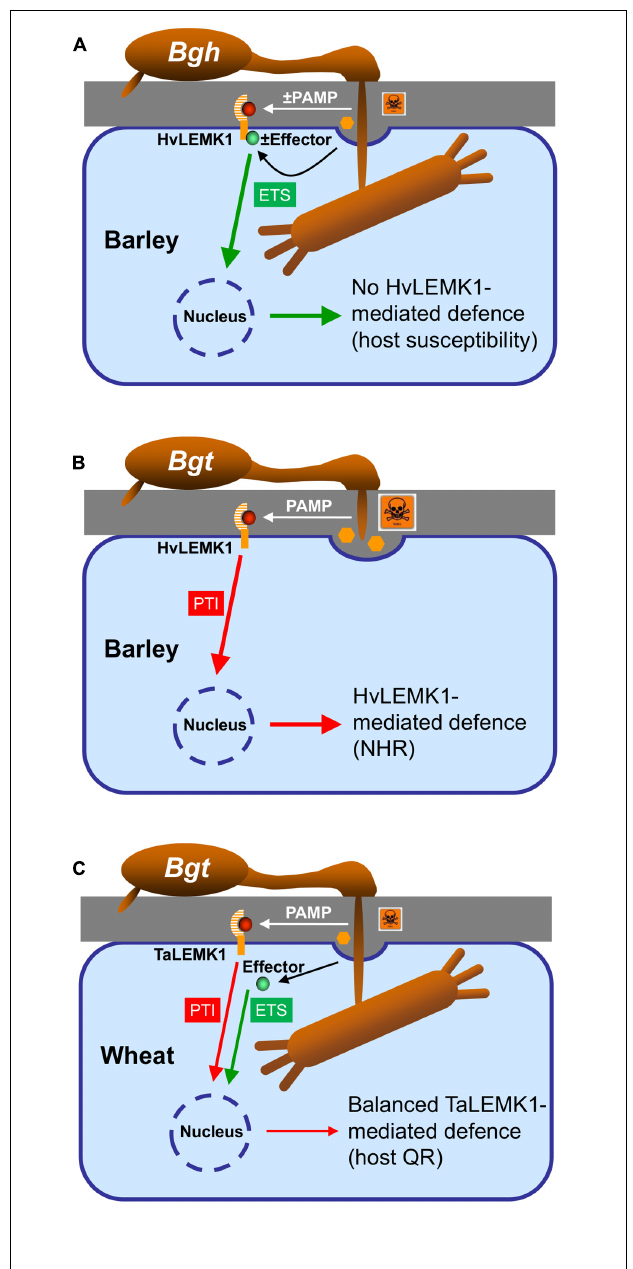
FIGURE 7 | Model of the role of LEMK1 in non-host resistance of barley and quantitative host resistance of wheat to Bgt . (A) In the susceptible host interaction, Bgh either prevents or masks the release of a PAMP (highlighted by “ ± ,” which otherwise would be recognized by HvLEMK1, or it releases an effector suppressing HvLEMK1-triggered PTI. (B) In the non-host-resistant interaction of barley with Bgt , HvLEMK1 recognizes the same/similar conserved PAMP without attenuation by an effector and triggers a strong PTI response. (C) During the interaction of wheat with Bgt , TaLEMK1 also recognizes the corresponding PAMP with high efficiency, but PTI is partially inhibited by other effector(s) from Bgt . (A–C) For simplicity the model only includes a proposed role of LEMK1 as PAMP receptor and ignores the possibility that it acts as co-receptor together with another RLK. In both scenarios, however, the outcome of the presence/absence of a PAMP or of a LEMK1-suppressing effector would be the same. NHR, non-host resistance; host QR, host quantitative